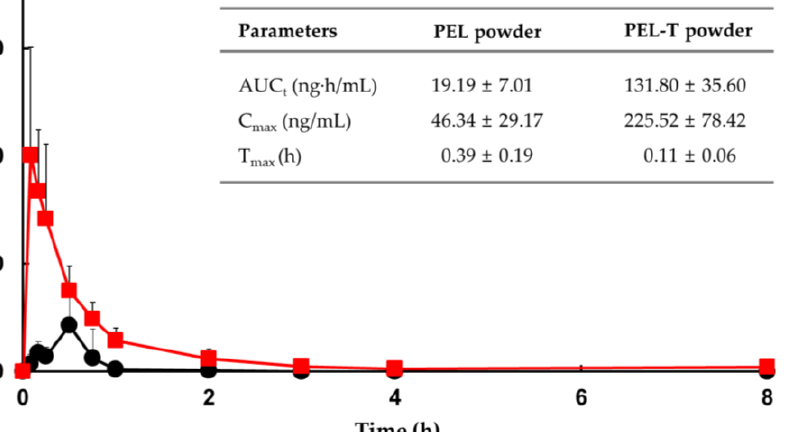
Figure 4. Mean ( ± S.D.) plasma concentration–time profiles of PEL in the plasma samples after a single oral administration of PEL-T (red) or PEL (black) powder to rats. PK parameters are summarized in the inset table. The data points and error bars represent the mean ± S.D. ( n =